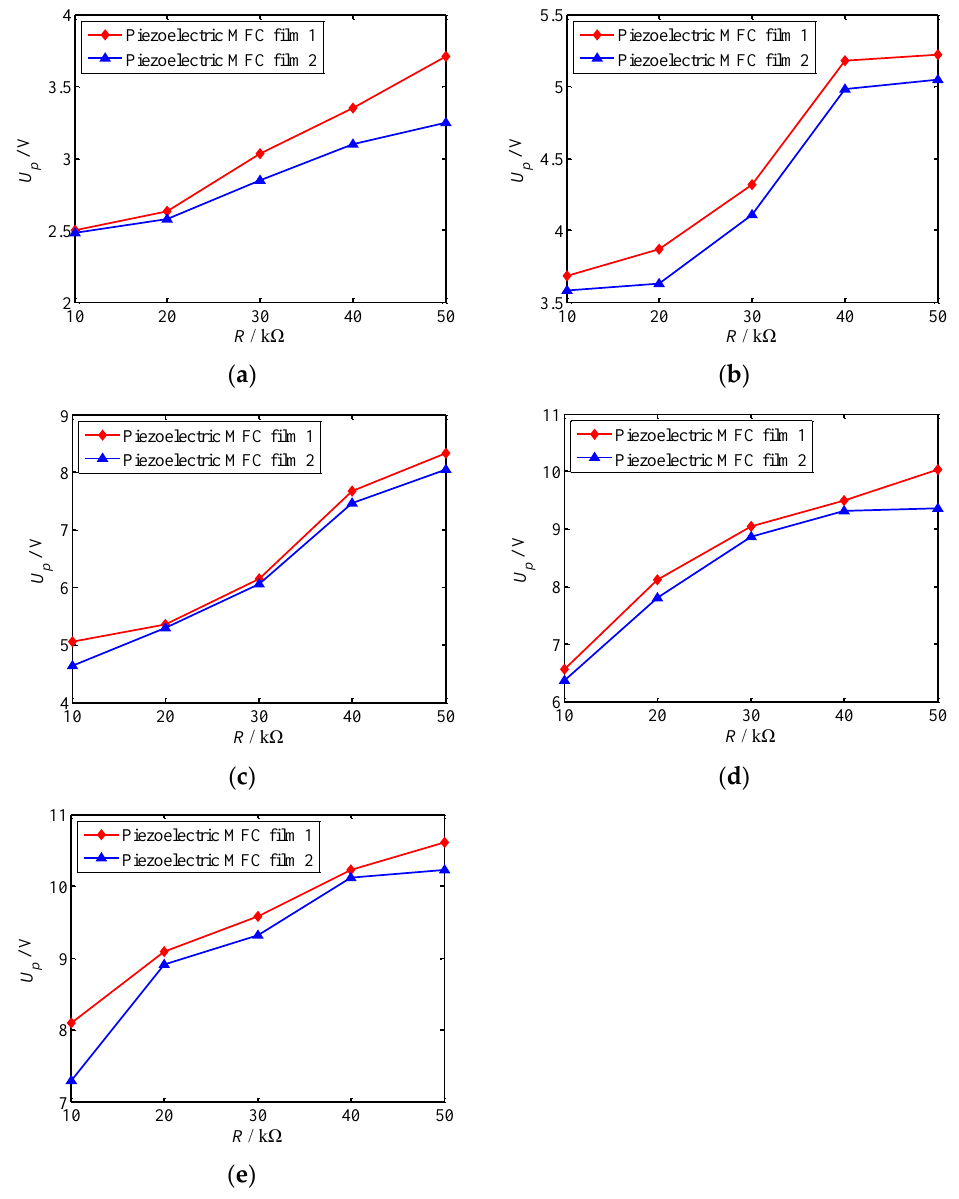
Figure 11. The output voltage varies with the load resistance under different excitation frequency.